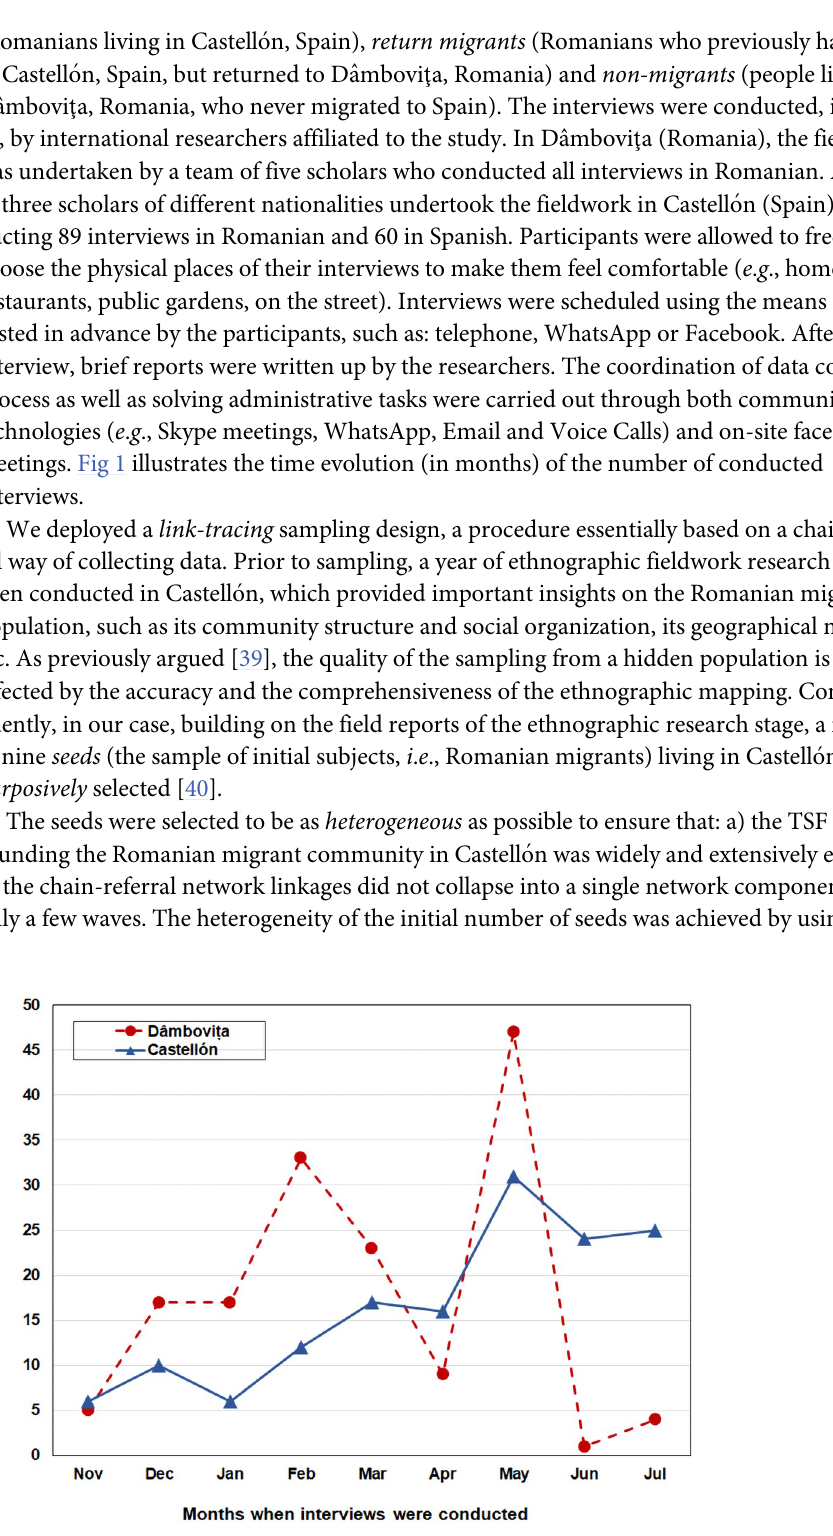
Fig 1. The process of link-tracing data collection, by month and location. The lines are indicating the time variation of the conducted interviews (red line for the Daˆmbovi ț a site, while blue for the Castello´n site).